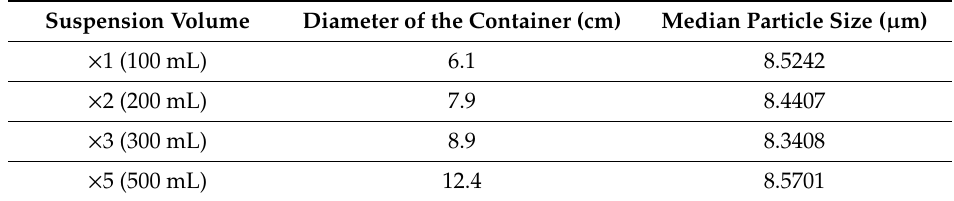
Table 4. Suspension volume, diameters of containers and obtained particle size in the scalability test.